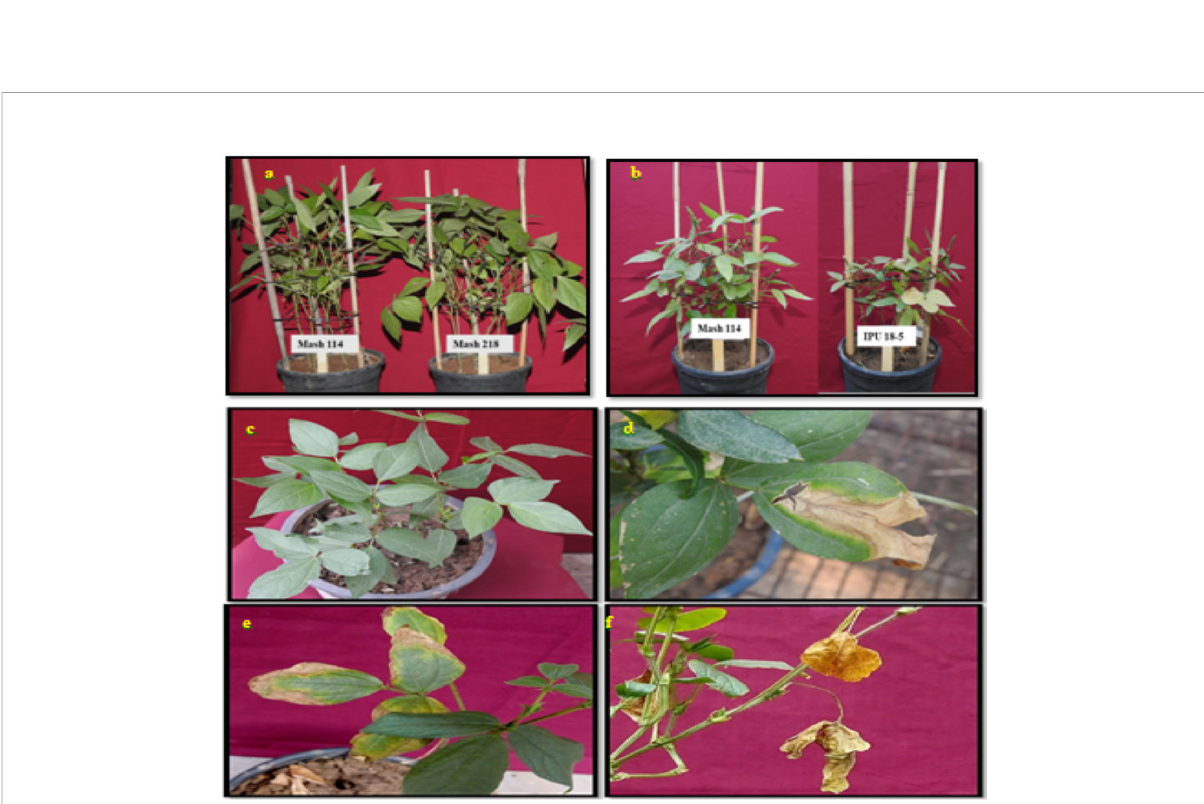
FIGURE 11 Morphological effects of heat stress on Urdbean plants; plant height under control environment (A) , reduced plant height under heat stress (HS) environment (B) , healthy leaves under control environment (C) , scorching of leaves under HS (D) , chlorosis in the HS (E) , Leaf senescence and abscissionin the HS (F)